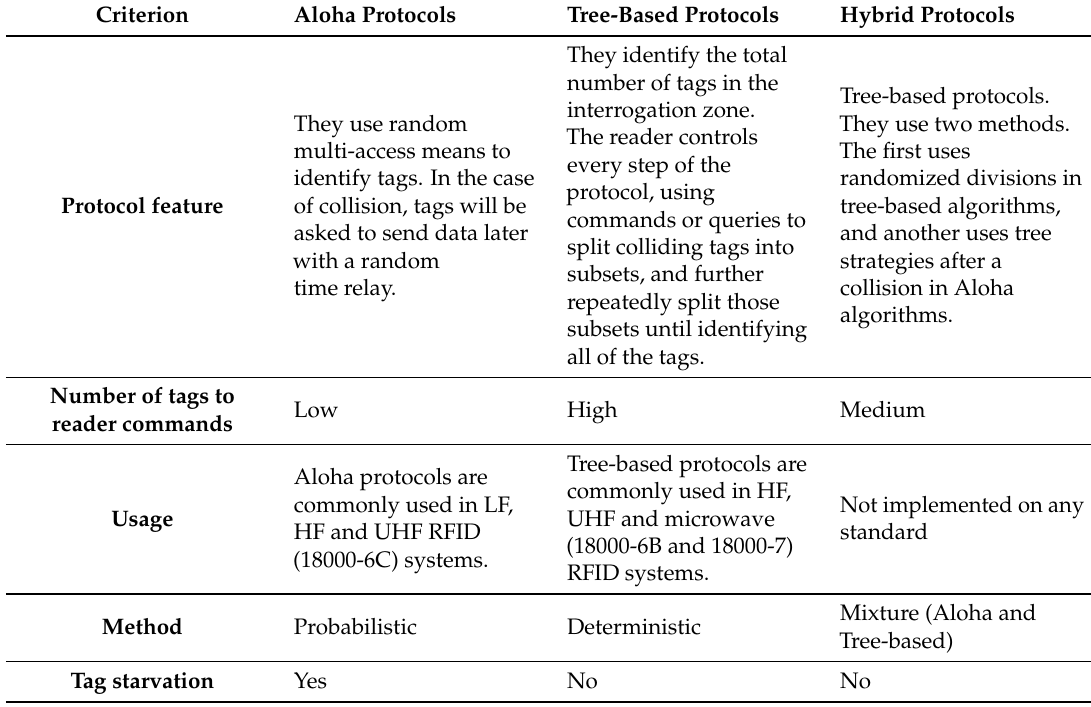
Table 6. A comparison of Aloha, Tree-based and Hybrid